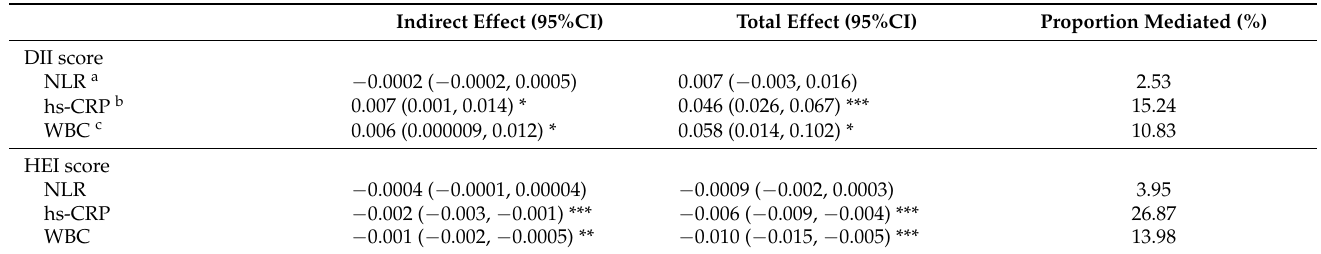
score, HEI score and hs-CRP was statistically significant ( β DII = 0.007, 95%CI: 0.001, 0.014; respectively. The mediating effect of central obesity influence on the relationship between DII score, HEI score, and WBC was statistically significant ( β DII = 0.006, 95%CI: 0.000009, total effect, respectively. Table 4. The weighted mediating central obesity on the association between dietary score and inflammation